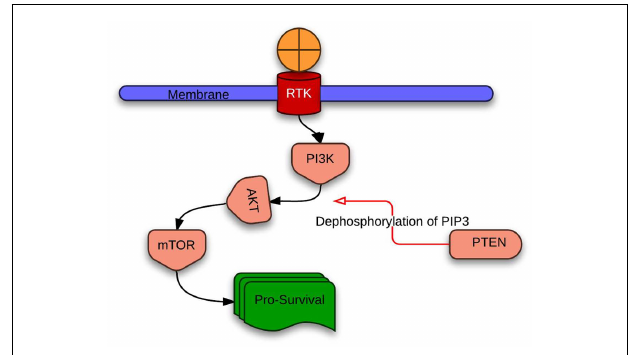
FIGURE 2 | Simplified sequence of PI3K/PTEN/AKT interaction affecting survival after growth factor binding to receptor tyrosine kinase . Red arrow indicates inhibitory